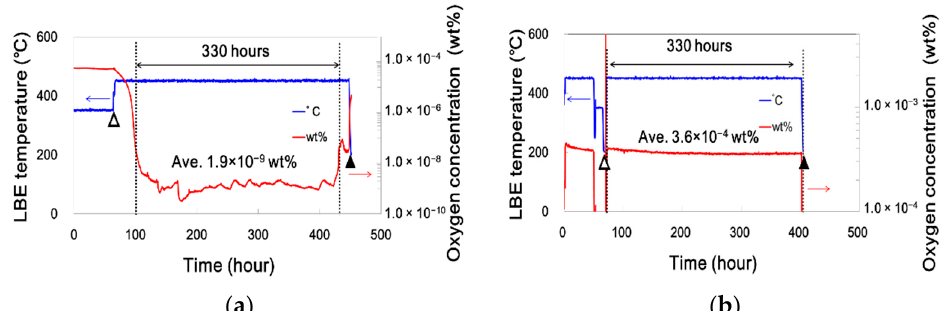
Figure 2. LBE temperature and oxygen concentration under corrosion tests for the 316L specimens. The corrosion tests were conducted for 330 h at ( a ) low oxygen concentration and ( b ) high (saturated) oxygen concentration in LBE at 450 °C. The triangles denote the insertion and extraction moments of the specimens as the open and solid triangles, respectively.